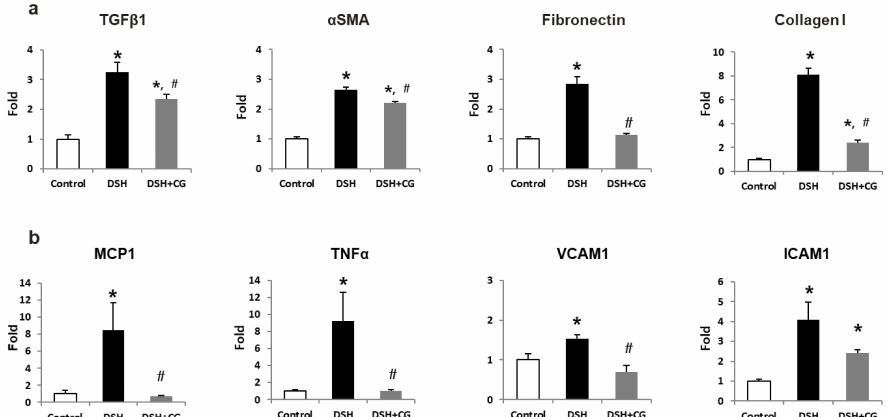
Figure 4. mRNAexpressionoffibrosis( a )andinflammatorymarkers( b )inthekidneysofdeoxycorticosterone acetate (DOCA)-salt hypertensive (DSH) rats and those treated with CG200745 (DSH + CG). Columns show real time PCR data. * p < 0.05 compared to controls. # p < 0.05 compared to DSH rats.